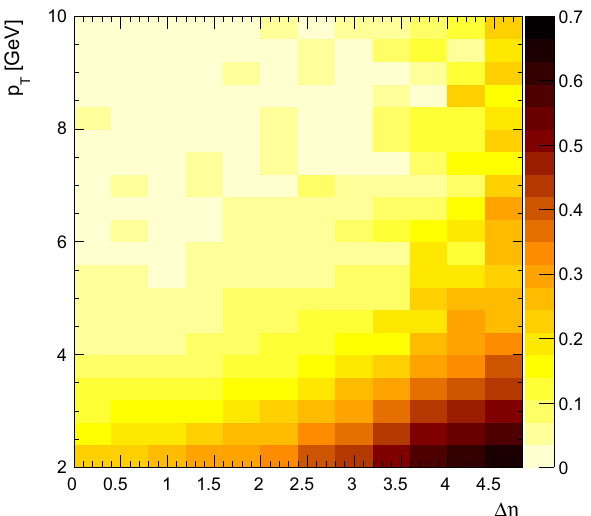
Fig. 1 Fraction of dijet + a charged particle cross section due to the DPS as a function of the p T of the charged particle and the pseudo- rapidity interval between the leading jet and the charged particle, Δη